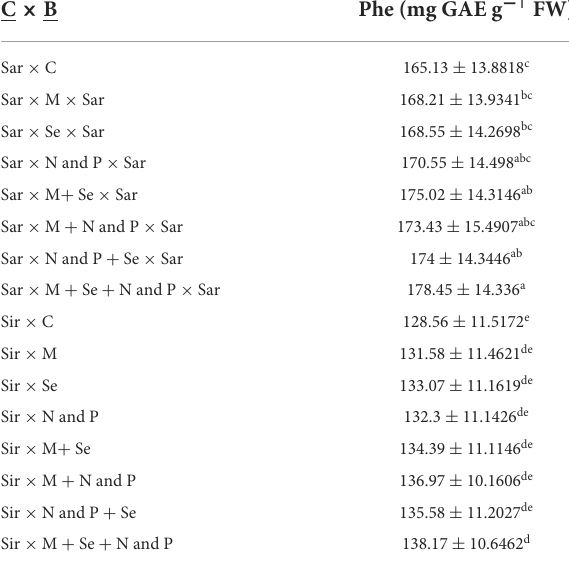
TABLE 10 Mean comparisons of the dual interactions of bio-fertilizers and cultivar on anthocyanin content and peroxidase activity in